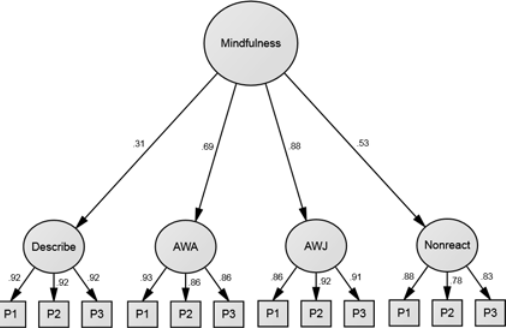
Fig 2. Confirmatory Factor Analysis results for the four-factor hierarchical model of the Five Facet Mindfulness Questionnaire [18], omitting the Observe facet, in Sample 2 ( N = 172). First-order latent variables represent the four facets and derive from item parcels (three per facet). Error terms are omitted for visual clarity. AWA = Act with Awareness; AWJ = Accept w/o Judgment; P1 to P3 = Parcels 1 to 3. All standardised coefficients are significant at the .01